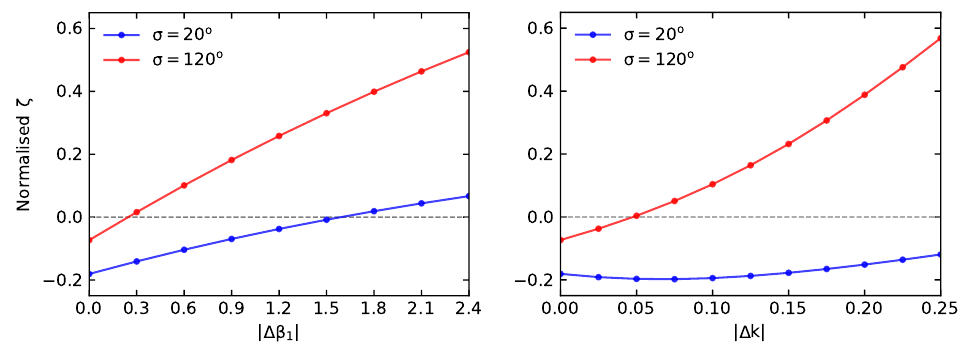
Figure 9. Change in normalised damping at σ = 20 ◦ and σ = 120 ◦ .